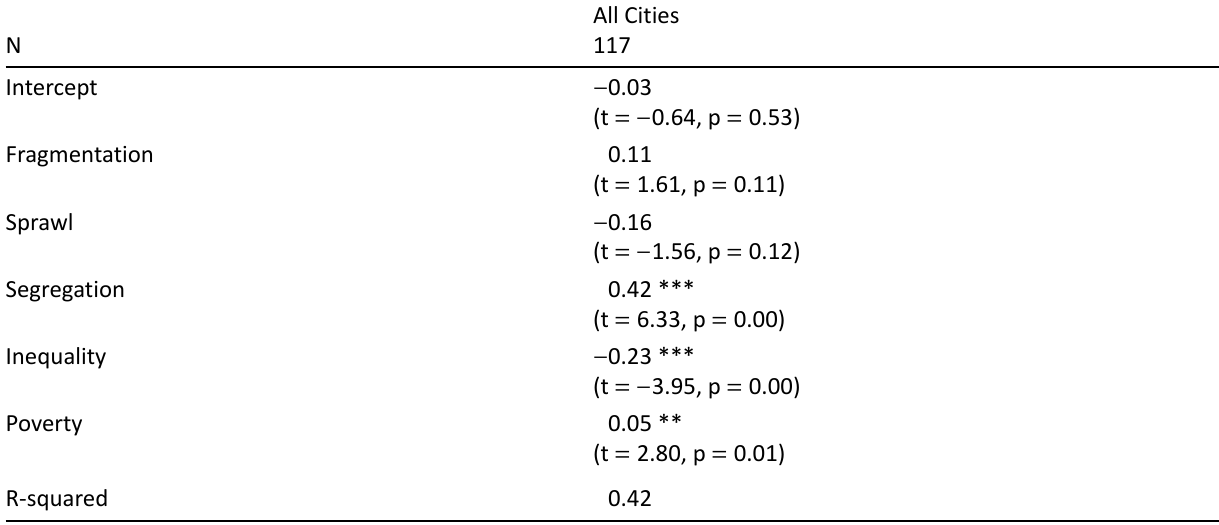
Table 4. Regression model highlighting relationships between PRIMED characteristics and economic vulnerability. All Cities